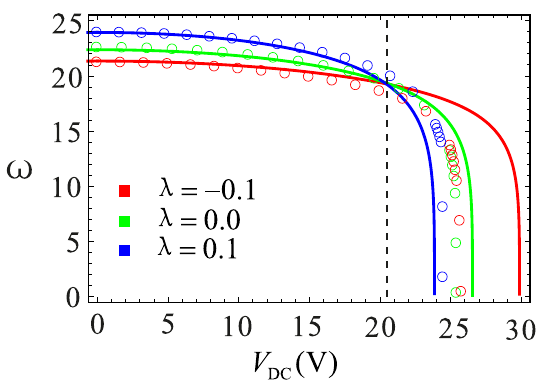
Figure 13. Relationship between DC voltage and equivalent frequency under different section parameters. The solid lines represent the analytic solutions. The circles represent the finite element solutions.